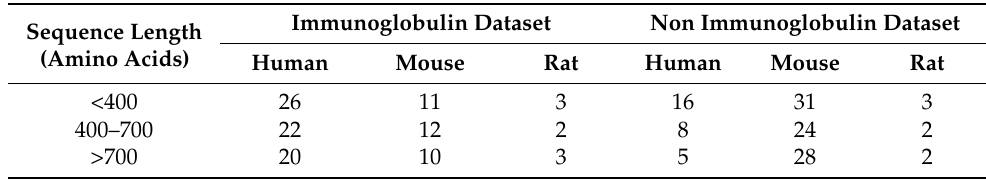
Table 1. Distribution of sample sequence lengths in immunoglobulin and non immunoglobu- lin